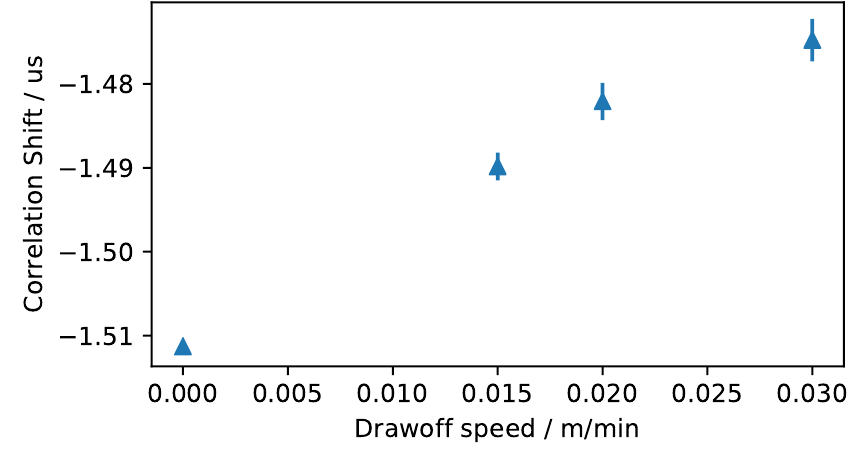
Figure 11. Connection of the Correlation Shift value in steady state condition and the pull speed during the pultrusion